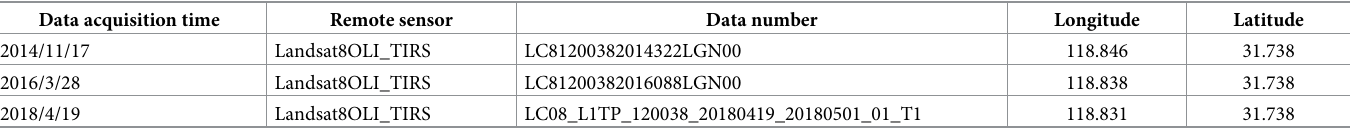
Table 1. The detailed information of remote sensing data.